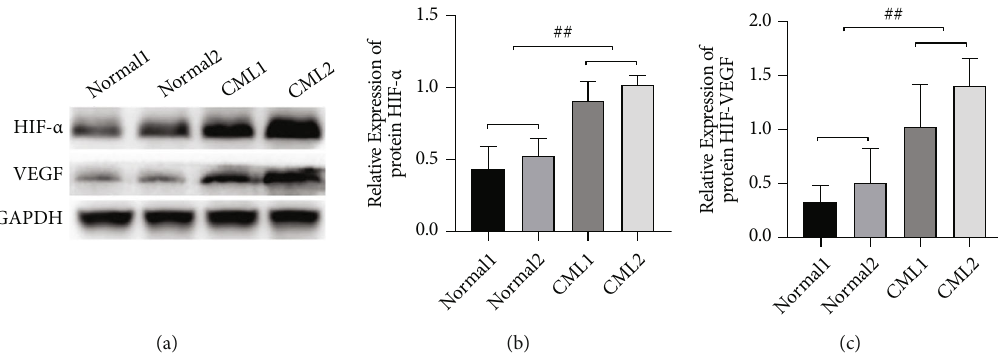
Figure 1: Expressions of HIF-1 α and VEGF proteins in the bone marrow of healthy individuals and CML patients: (a) Western blot assays of protein expression; (b) HIF-1 α protein gray values; (c) VEGF protein gray values. ## P < 0 : 01